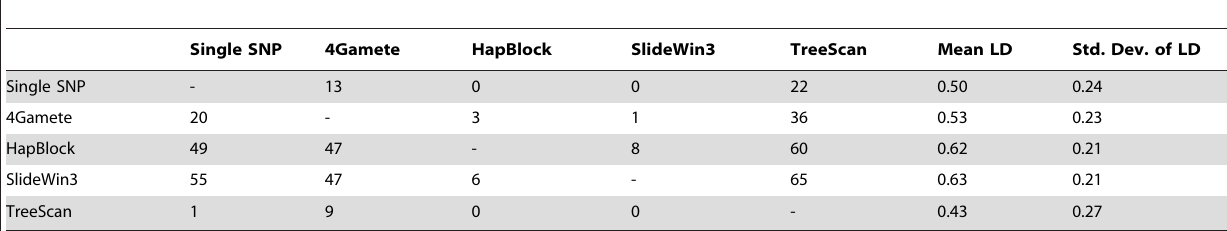
Table 5. Linkage disequilibrium between QTL and its highest LD marker for single SNPs and each of the different blocking